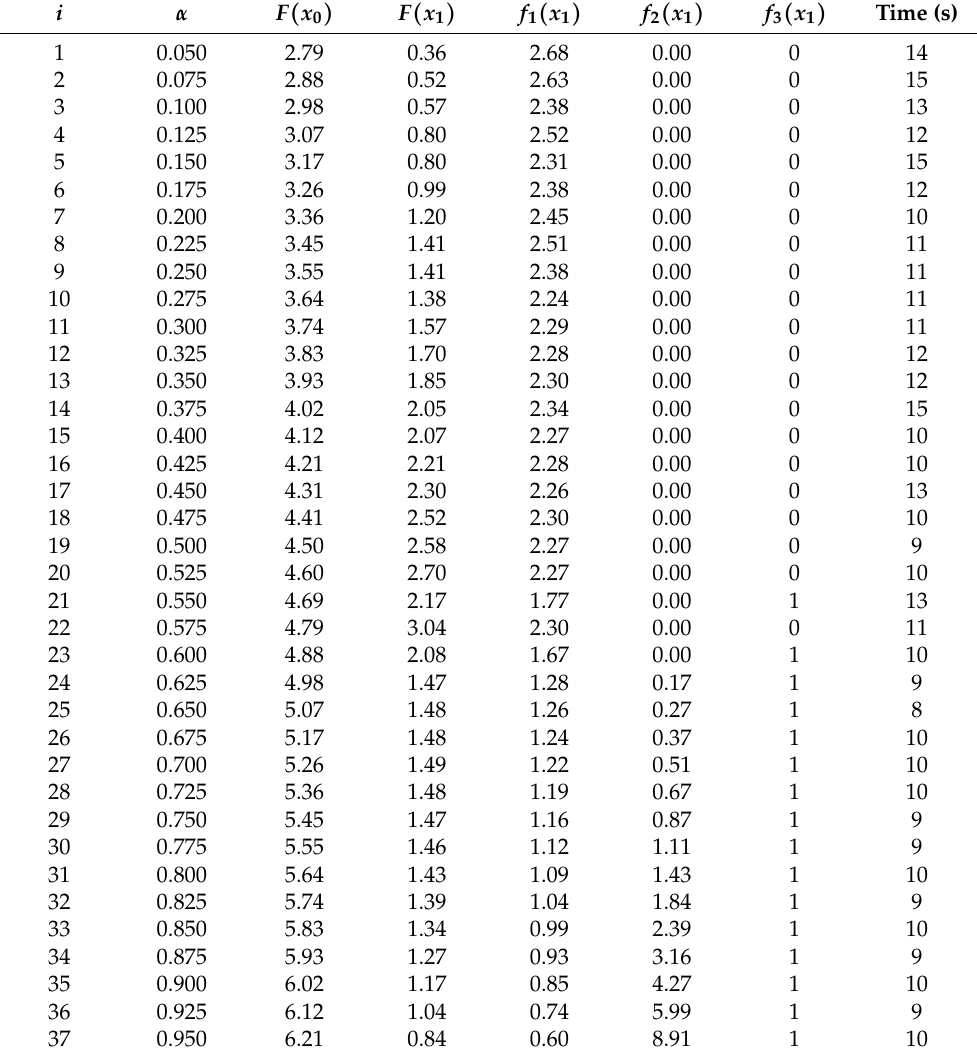
Table 4. Initial and optimal objective